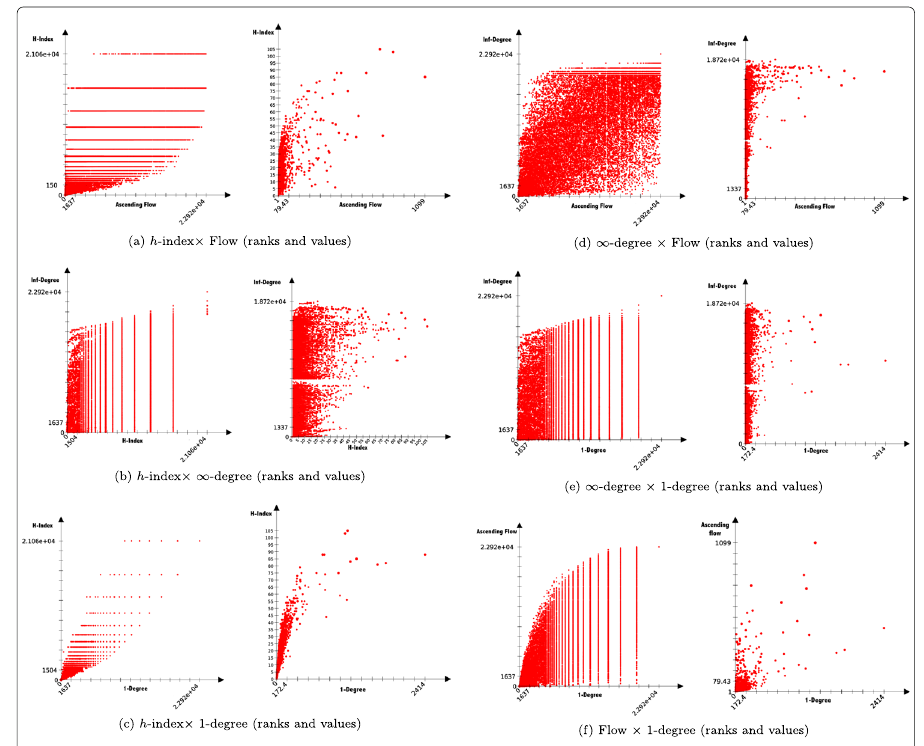
Fig. 5 Comparative distribution of ranks and values among: • h -index ( a , b , c ), • ascending flow ( a , d , f ), •∞ -degree – i.e. number total of generated publications ( b , d , e ), • and 1-degree – i.e. number of citations of a publications ( c , e , f ). The plots illustrate the difference between what those statistics are measuring